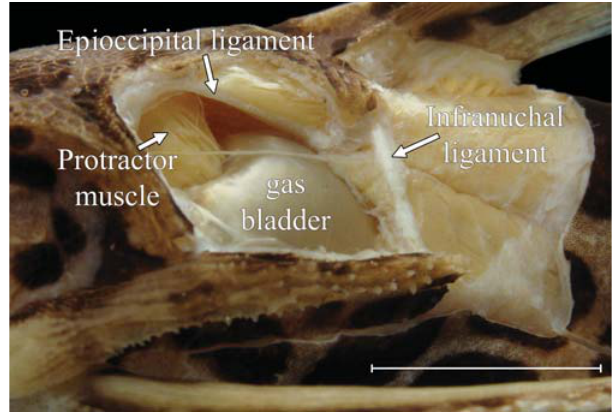
Fig. 4 . Tympanic area in lateral view of Liosomadoras oncinus , MZUSP 93497, 74.8 mm SL. Scale bar = 10